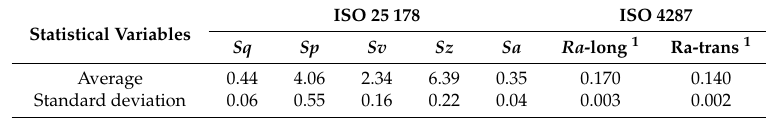
Table 4. The parameters of the surface microgeometry of the TiCN-MP coating ( µ